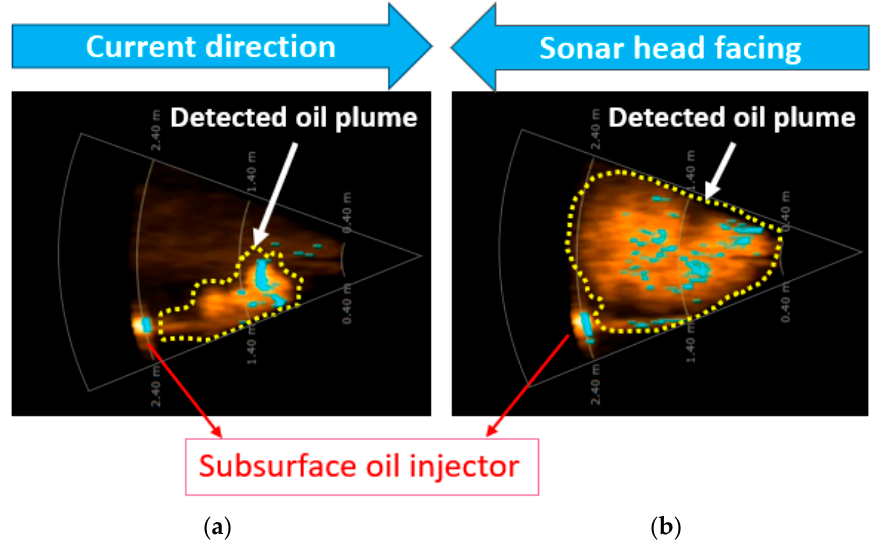
Figure 4. The BV5000 (Teledyne Blueview) sonar images captured in seawater wave tank tests: five seconds ( a ); and ninety seconds after oil release ( b ).